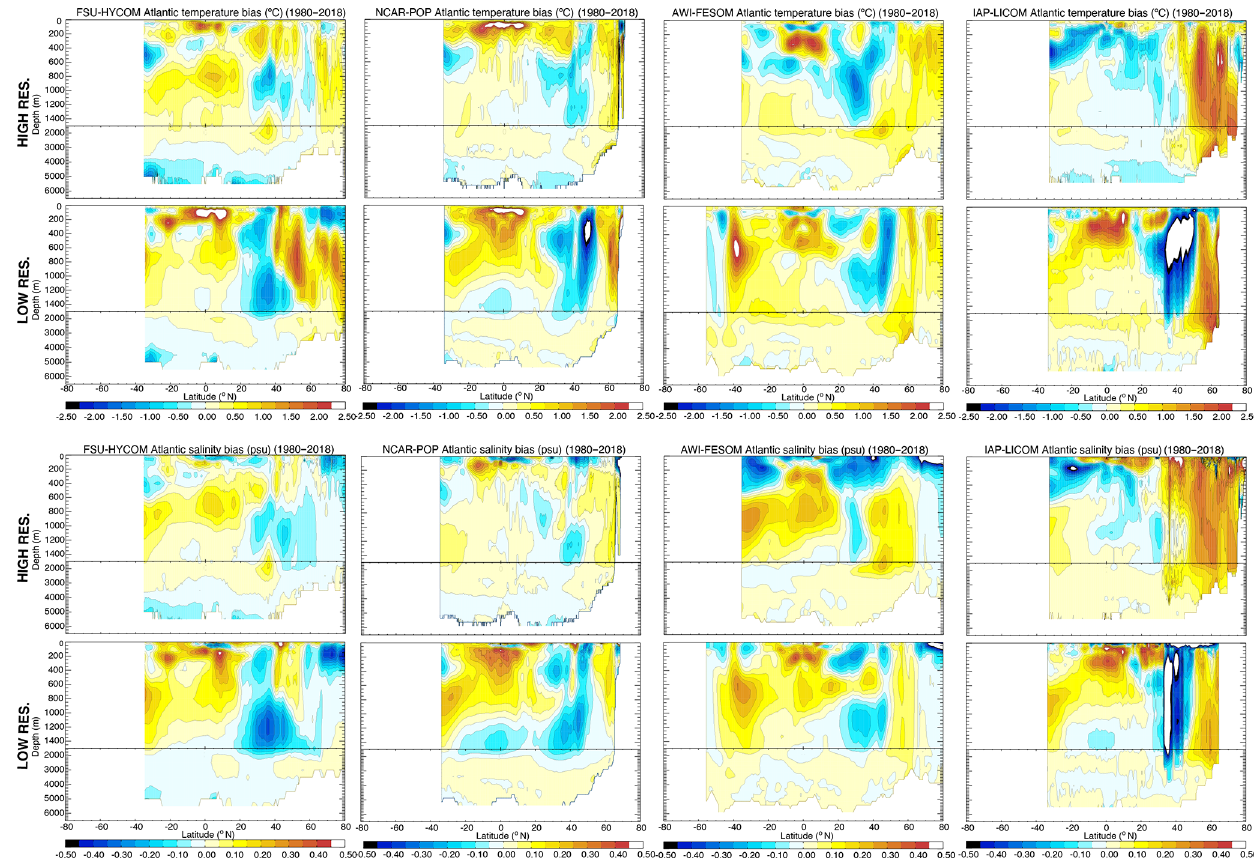
Figure 12. Atlantic zonal temperature ( ◦ C) and salinity (psu) difference with the climatology used to initialize the